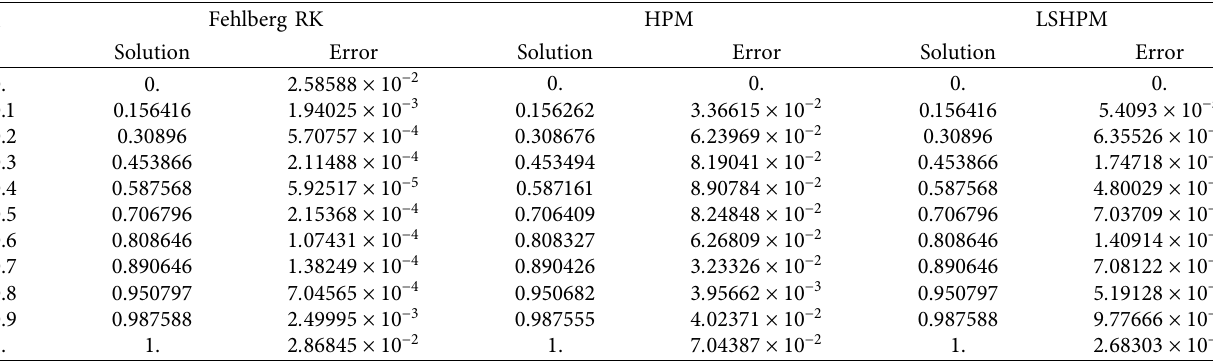
� 1 , and M � 0 . 3 in case of no slip. g p